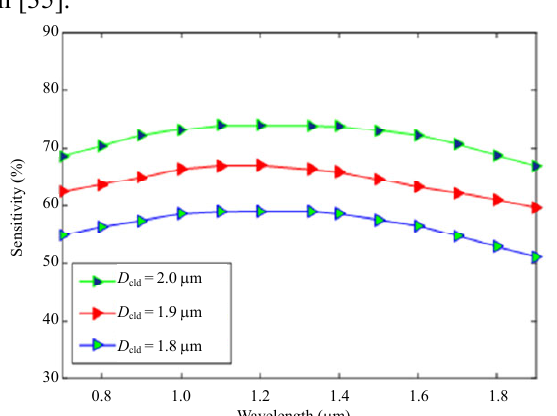
Fig. 3 Variation of sensitivity verses applied wavelength due to tuning the cladding diameter when other parameters are kept constant.